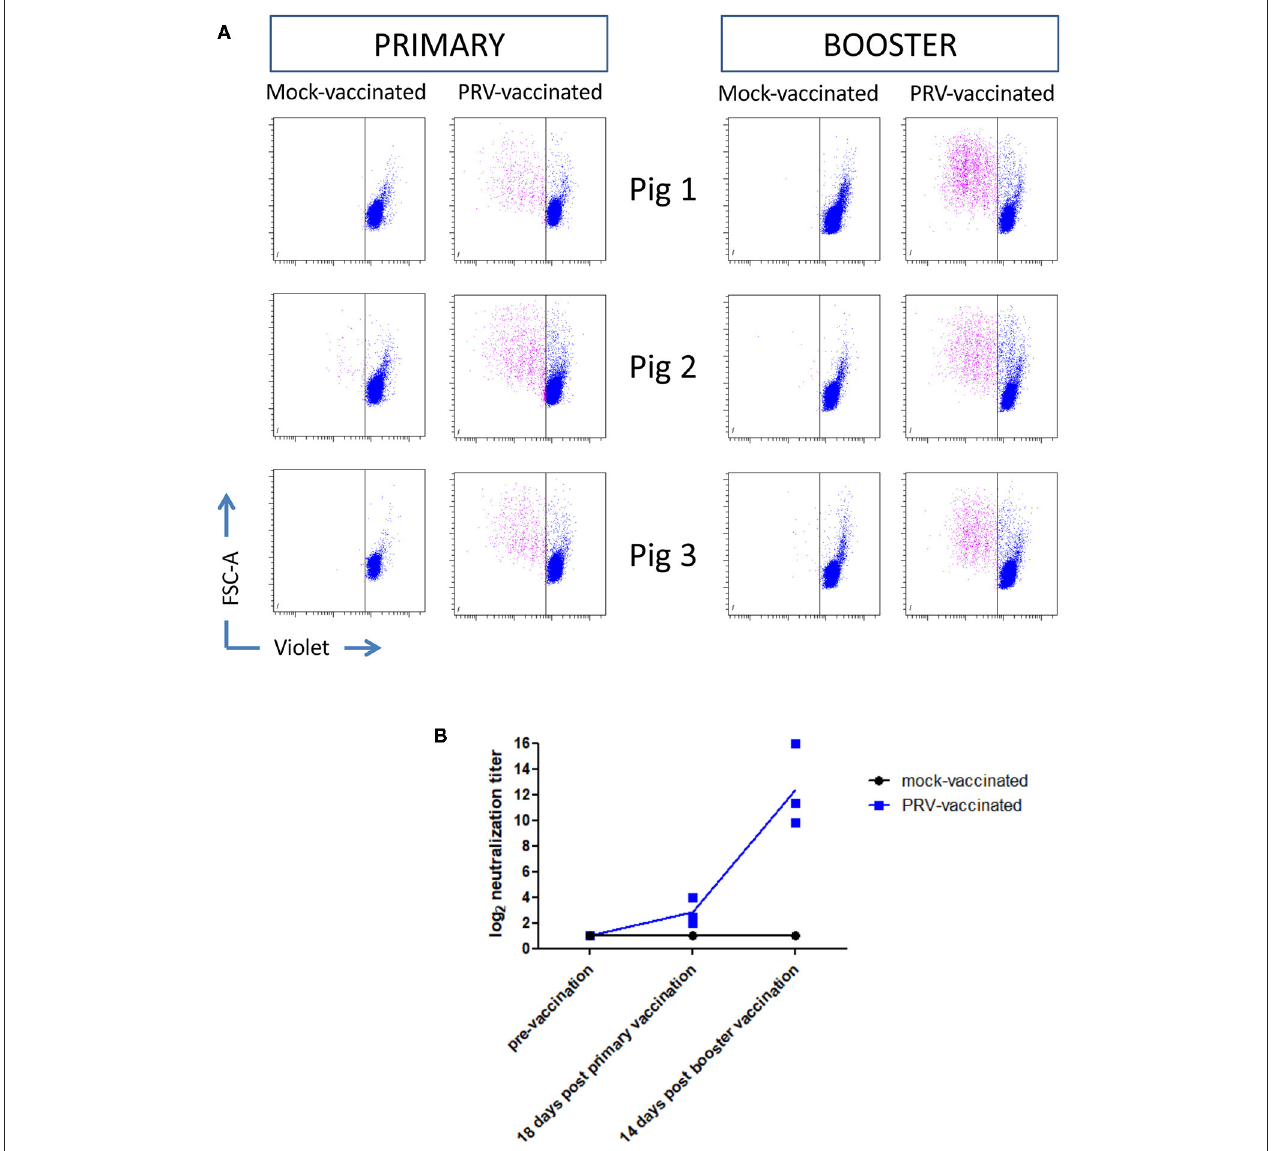
FIGURE 2 | PRV vaccination induces PRV-experienced T cells and seroconversion. (A) Flow cytometry analysis of violet labeled PRV-stimulated PBMC isolated from mock-vaccinated pigs ( n = 3) and PRV-vaccinated animals ( n = 3) at 18 and 14 days post primary and booster vaccination, respectively, is shown. Dot plots show the proliferation-induced dilution of the violet level of the CD3 + T cell fraction after 4 days. (B) Seroconversion in mock-vaccinated and PRV-vaccinated pigs was tested by a virus neuralization assay at different timepoints: pre-vaccination, 18 days post primary vaccination, and 14 days post booster vaccination. The log equivalent of the serum dilution able to neutralize 100 PFU PRV is reported as the neutralization titer. Dot plot shows the results of the three animals in each group (mock- and PRV-vaccinated) and the mean values are connected with a